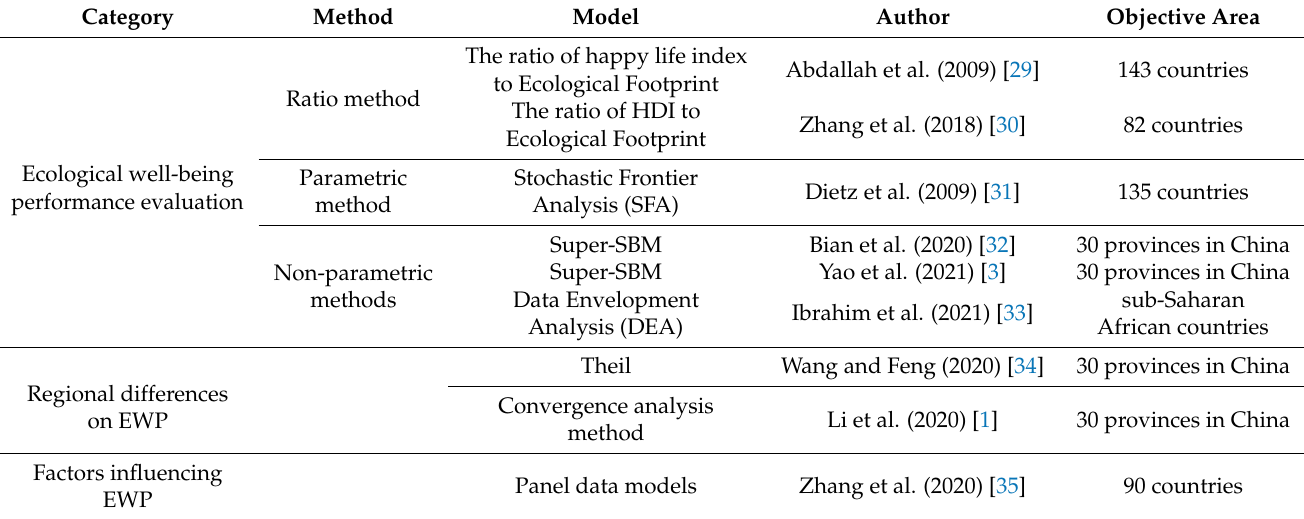
Table 1. Studies related to ecological well-being